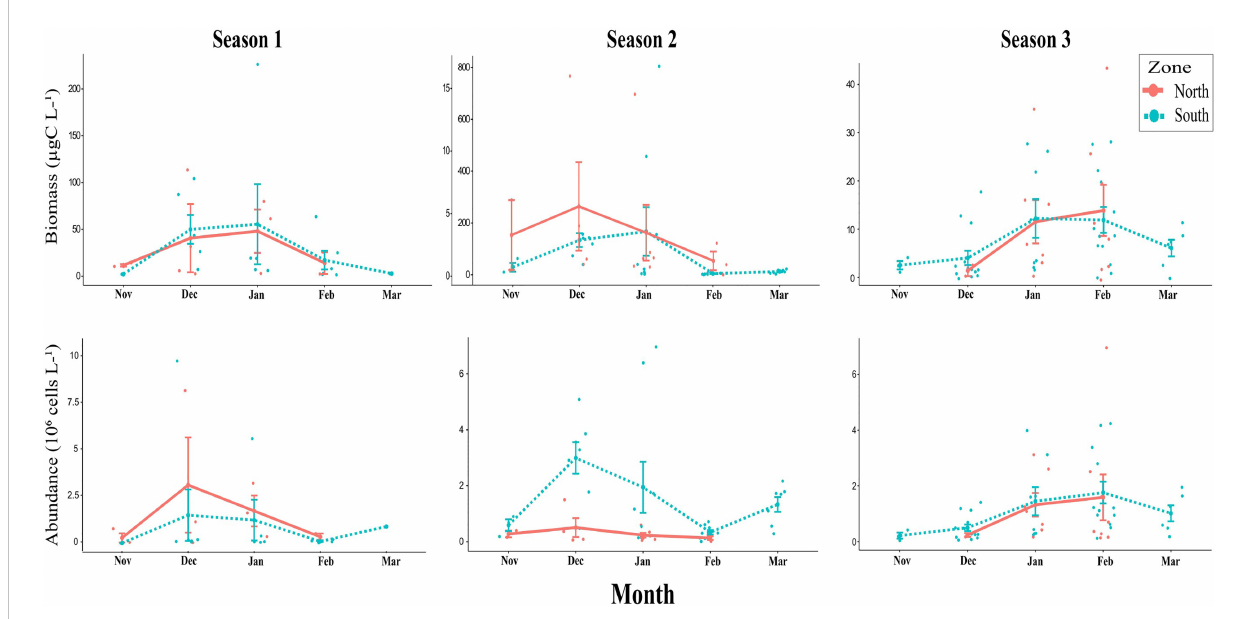
FIGURE 4 Biomass (µgC L -1 ) and abundance (cells L -1 ): monthly averages and standard deviation for the three consecutive summers from November to March in North and South zones, the exact values are depicted by colored points. Note that the y axes values varied between years and that biomass in Season 2 has two different y axes, the one to the left for the northern zone and the right one for the southern